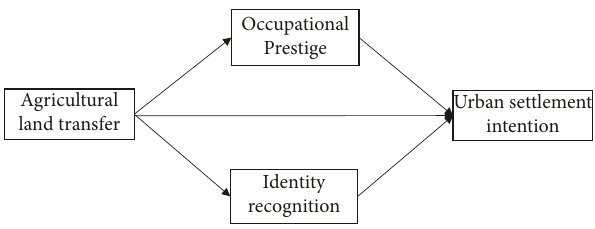
Figure 1: Model of the influence mechanism of agricultural land transfer on urban settlement